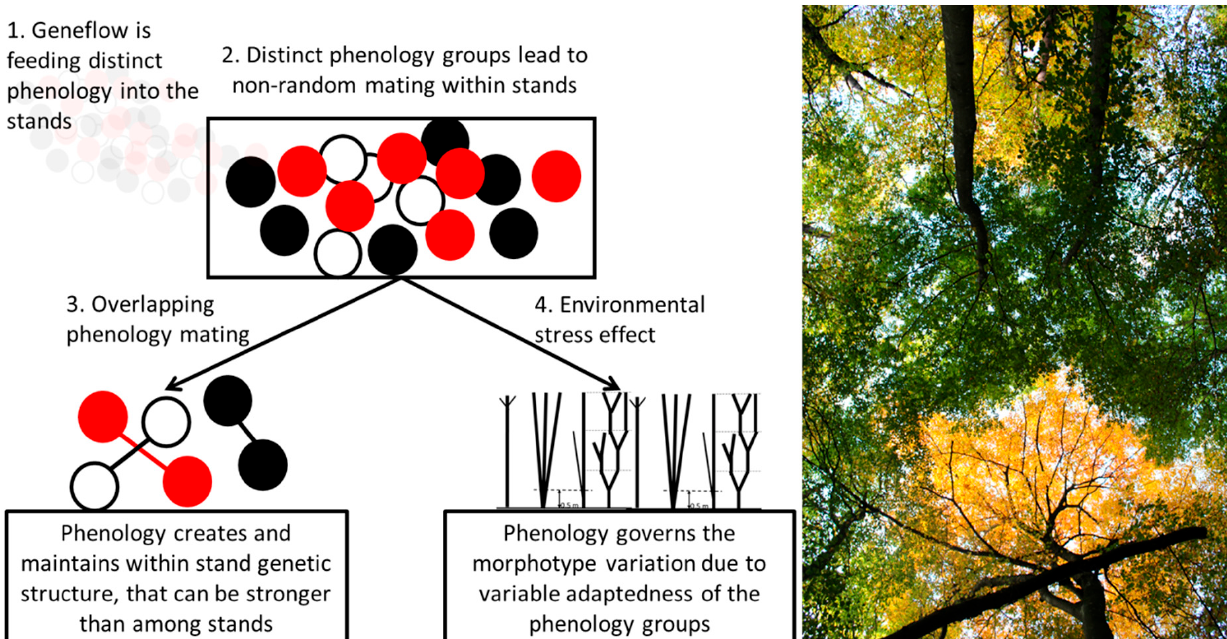
Figure 5. The phenology-morphology-genetic structure association model in European beech stands as supported by the findings of our study. (1) the geneflow feeds the genetic diversity together with distinct phenology into the stands; (2) distinct phenology groups develop (marked with color) and (3) leads to deviations for random mating that is reflected by forming distinct genetic groups (confirmed by association among the SSR genetic groups and phenology in this study) and in absence of strong selective pressure within a region these groups within stands can be stronger differentiated than stands in that particular region; (4) the differences in adaptedness of the phenology groups causes variation in stem quality morphotype (as found here by the association among phenology and stem quality indexes). Right is a photographic illustration of the above, where the tree of a European beech tree of an early leaf sentence contains stem forking defect lower dawn than the trees of late leaf sentence in JURA stand.